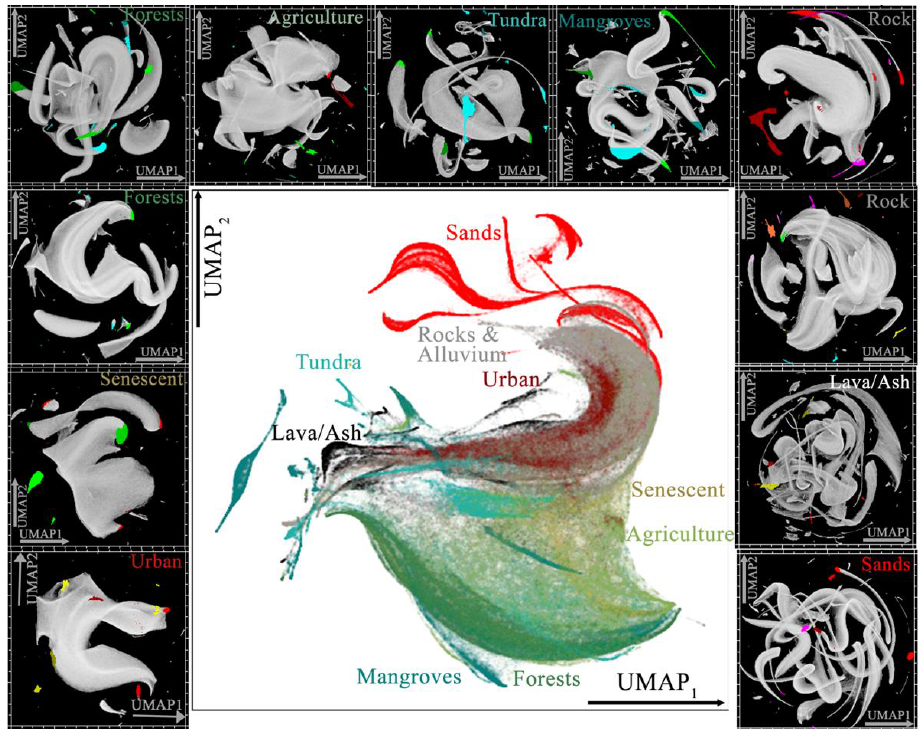
Figure 16. UMAP summary. Urban and senescent show highly continuous manifolds. Forests, agriculture, tundra, and mangrove show increasing clustering/decreasing continuity, respectively. Of the geologic scenes, rocks and alluvium show more continuous manifolds, with lava/ash and sands showing highly sinuous, clustered manifolds with a large number of distinct apexes.